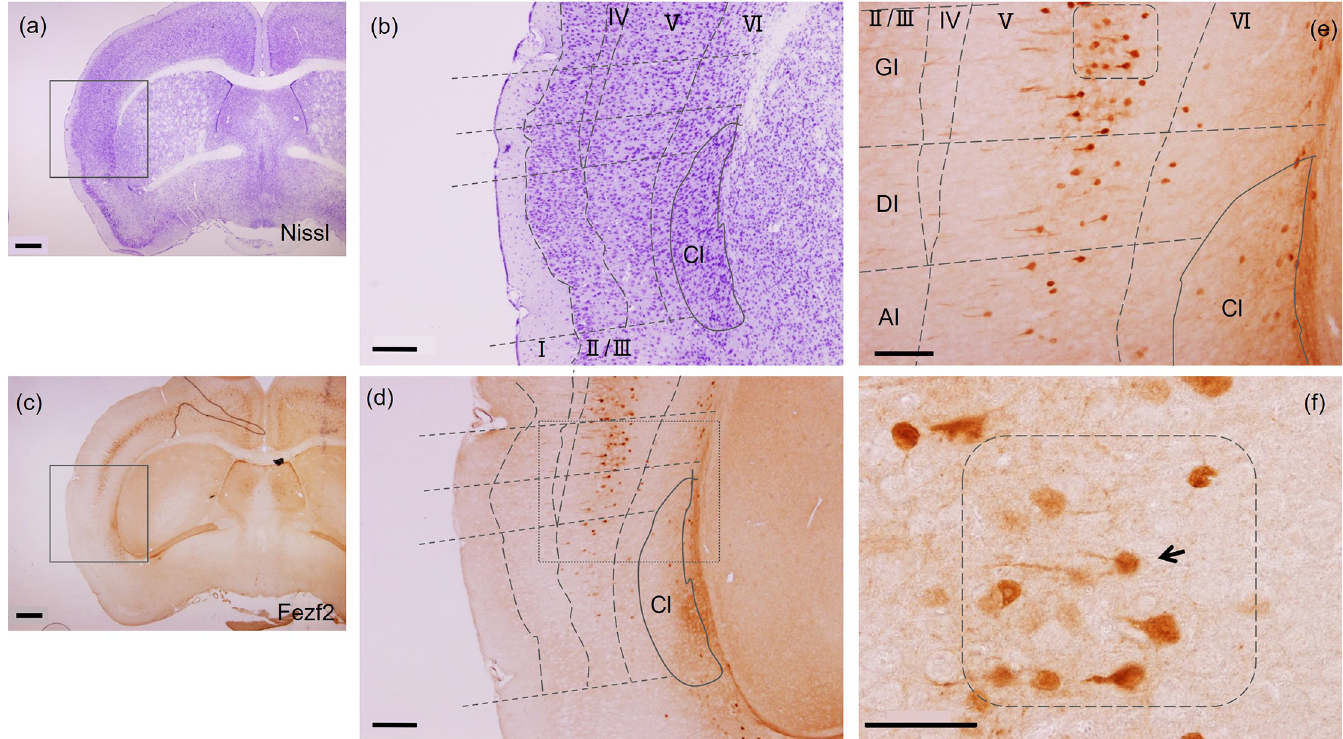
Fig 2. Fezf2-positive neuron exhibiting fork cell-like shape, having two apical dendrites in layer V neurons of the mouse insular cortex. A (a), (b), are images taken from the same section Fig 1A4, and (c), (d), (e), (f) are images taken from the same section Fig 1B4. Fezf2 was expressed in layer Ⅴ and Ⅵ with most neurons being densely accumulated in layer V (GI and DI). (a), (b); Nissl staining. (c)—(f); Fezf2. (b), (d) are the higher magnification images of the squares in panels (a), (c), respectively. (e) is the higher magnification image of the square in panel (d). (f) is the enlarged image including the rounded rectangle in panel (e). A Fezf2-positive neuron exhibiting fork cell-like shape, having two apical dendrites, is indicated by an arrow. No VENs-like shaped (bipolar) cells were identified. Scale bars (a), (c): 500 μ m, (b), (d): 200 μ m, (e): 100 μ m, (f): 50 μ m.